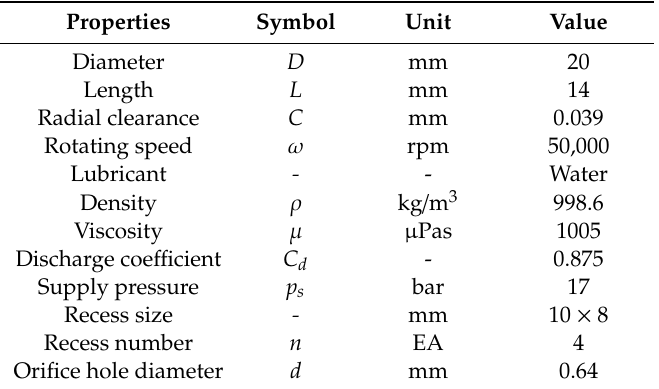
Table 2. Design parameters of hydrostatic bearing [22].